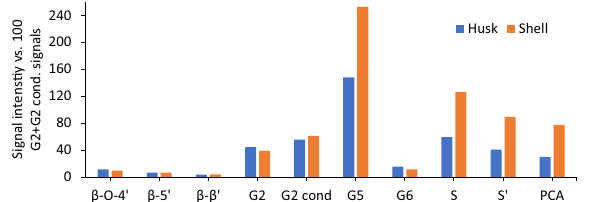
Figure 4. Abundance of HSQC NMR signal intensities of different lignin C–H units relative to 100 G2 + G 2,cond units for lignin isolated from 1:10 g/g biomass (husk and shell) and [DMBA] [HSO 4 ] with 20 % water at 170 °C for 45 min durations (monoplicate measurement).